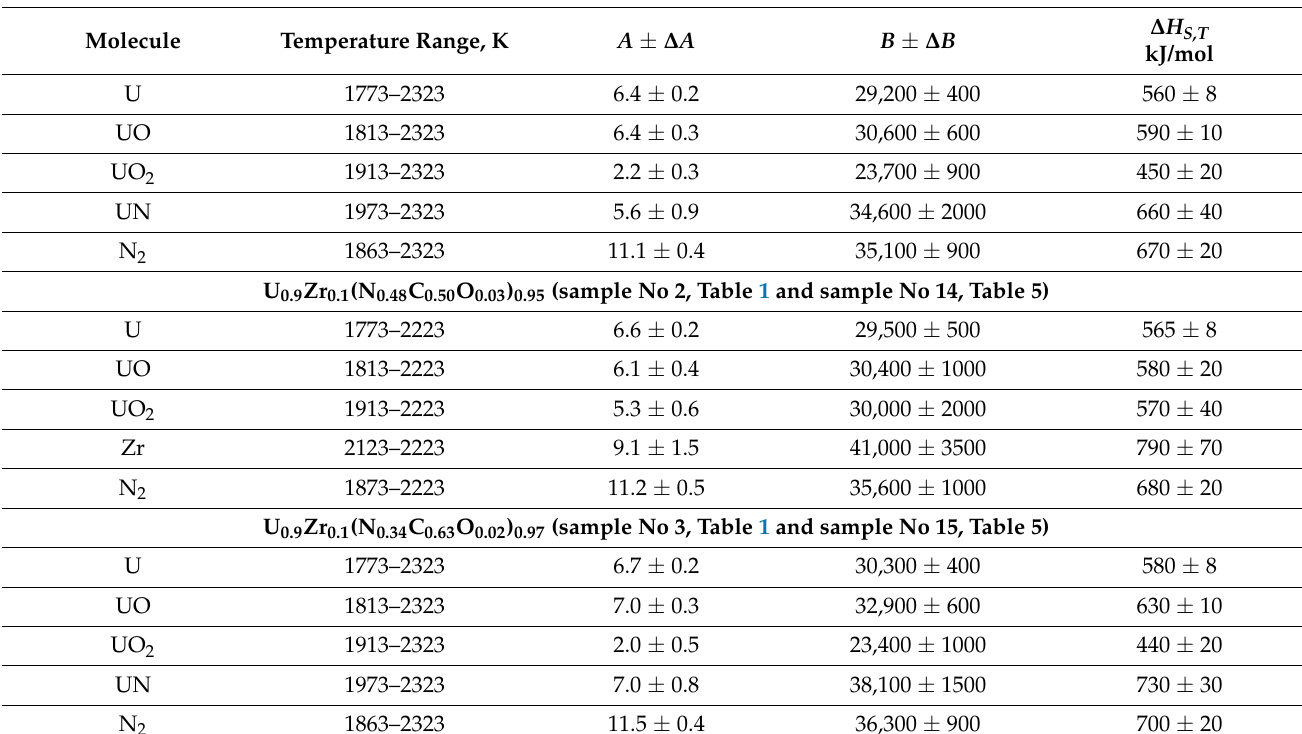
Table 3. Parameters of the temperature dependence of the partial pressures of the gas phase compo- nents over uranium-zirconium carbonitrides in the form lgP ( M Π a ) = A − B / T and the sublimation heat (this